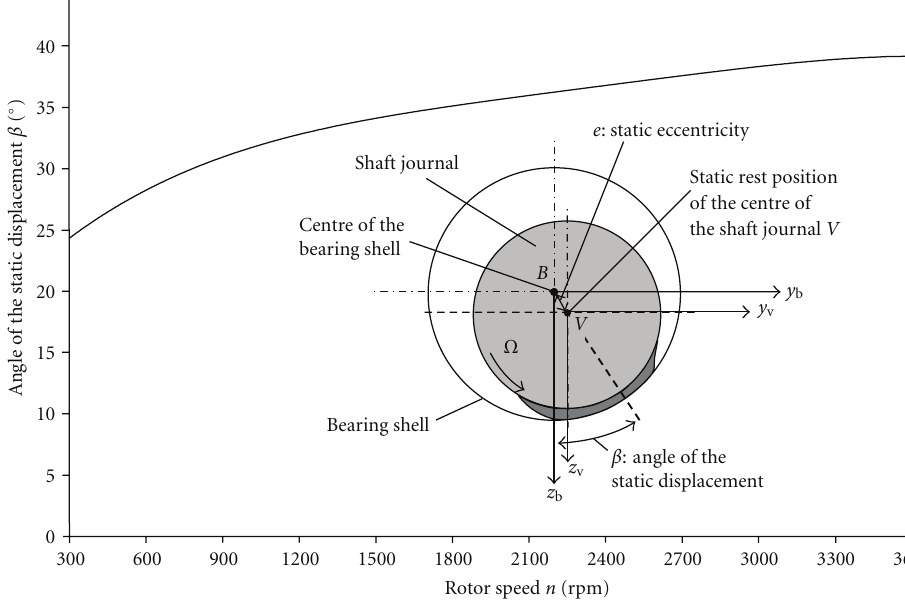
Figure 8: Angle β of the static displacement in the sleeve